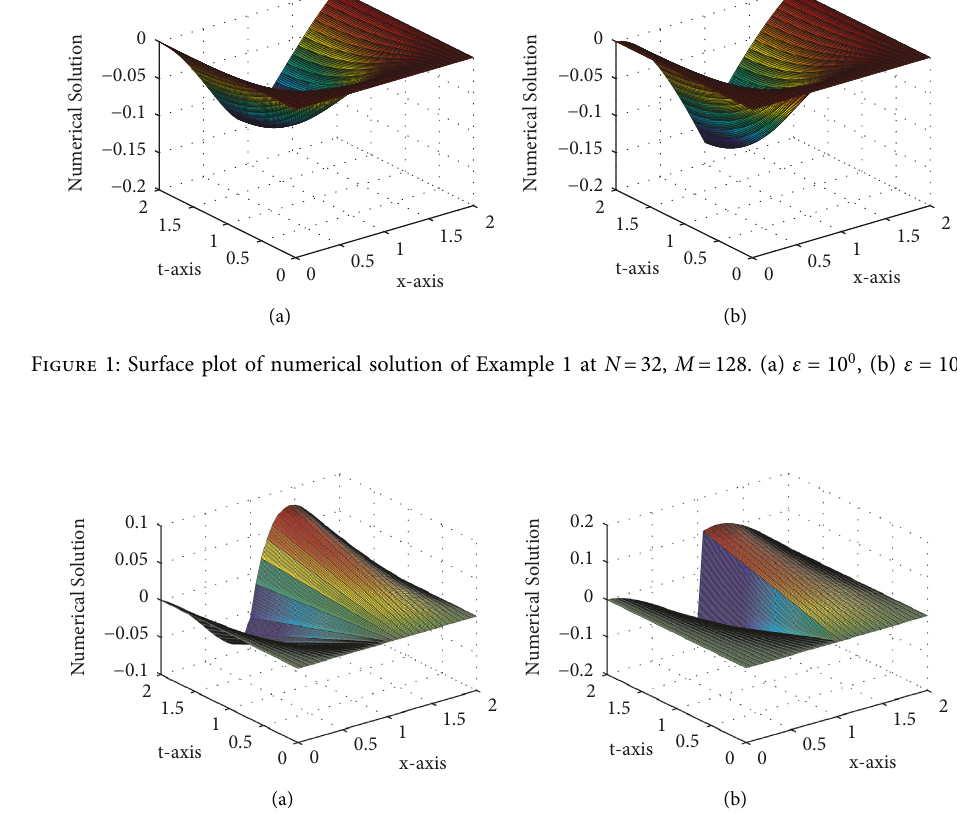
Figure 2: Surface plot of numerical solution of Example 2 at N � 32, M � 128. (a) ε � 10 0 , (b) ε � 10 − 4 .